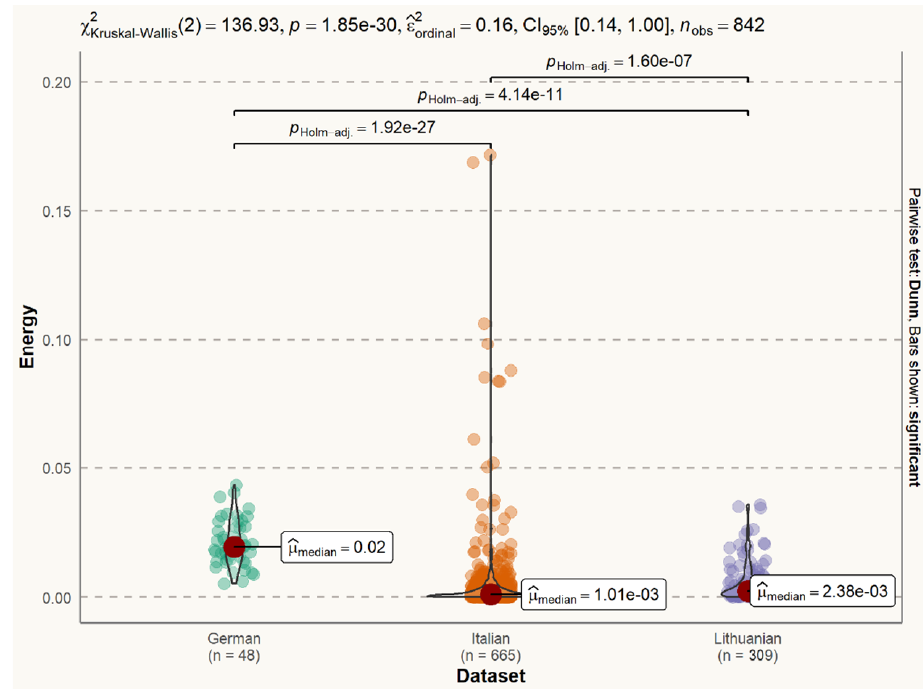
Figure 4. Statistical distribution of voice signal energy in datasets. The difference between the German and Italian datasets is statistically significant ( p < 0.001). The difference between the German and Lithuanian datasets is statistically significant ( p < 0.001). The difference between the Italian and Lithuanian datasets is statistically significant ( p < 0.001).